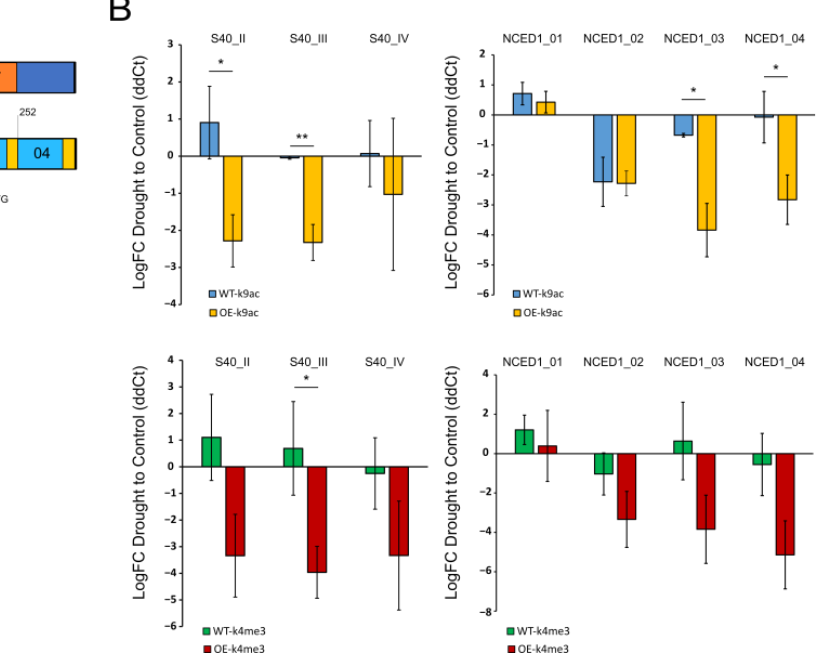
Figure 4. ChIP-qPCR analysis of drought-stress-related loading of ATG and the proximal promoter region of HvS40 and HvNCED1 with euchromatic marks H3K4me3 and H3K9Ac in the leaves of oeW1-2 . ( A ) Schematic illustration of ATG and promoter region of HvS40 and HvNCED1 , indicating sectors determined by qPCR . ( B ) ChIP qPCR of the investigated regions showing the drought-stress- induced change in loading with euchromatic marks H3K4me3 and H3K9Ac compared to controls. Each graph bar represents the average value from 3 separate replications, and the error bar shows the SEM. The asterisks above the graph bar show statistically significant differences according to Student’s t -test with * p < 0.05 and ** p < 0.01.